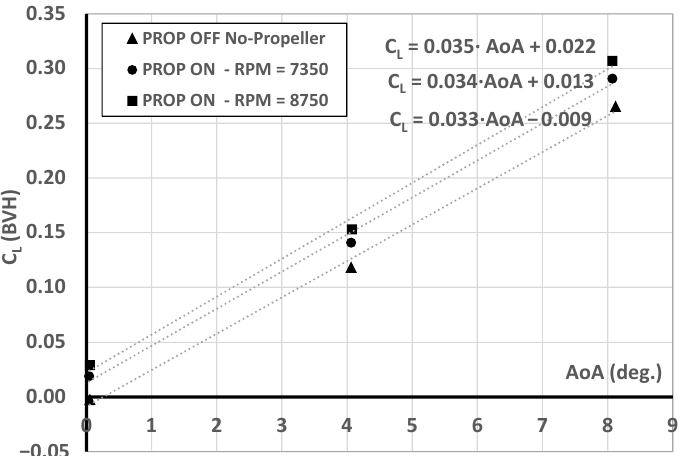
Figure 14. Indirect propulsive effect on the lift coefficient, Re = 315,000, IU rotation at two RPM settings.